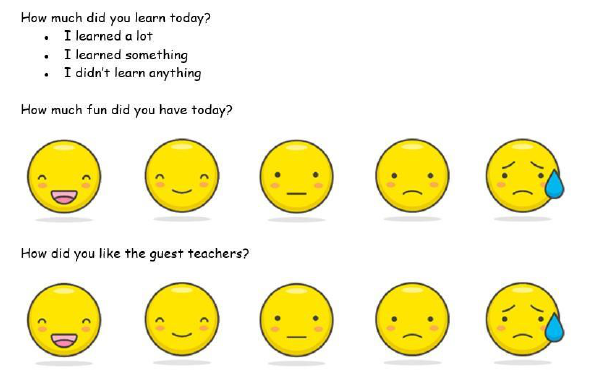
Figure 1 Children ’s program evaluation